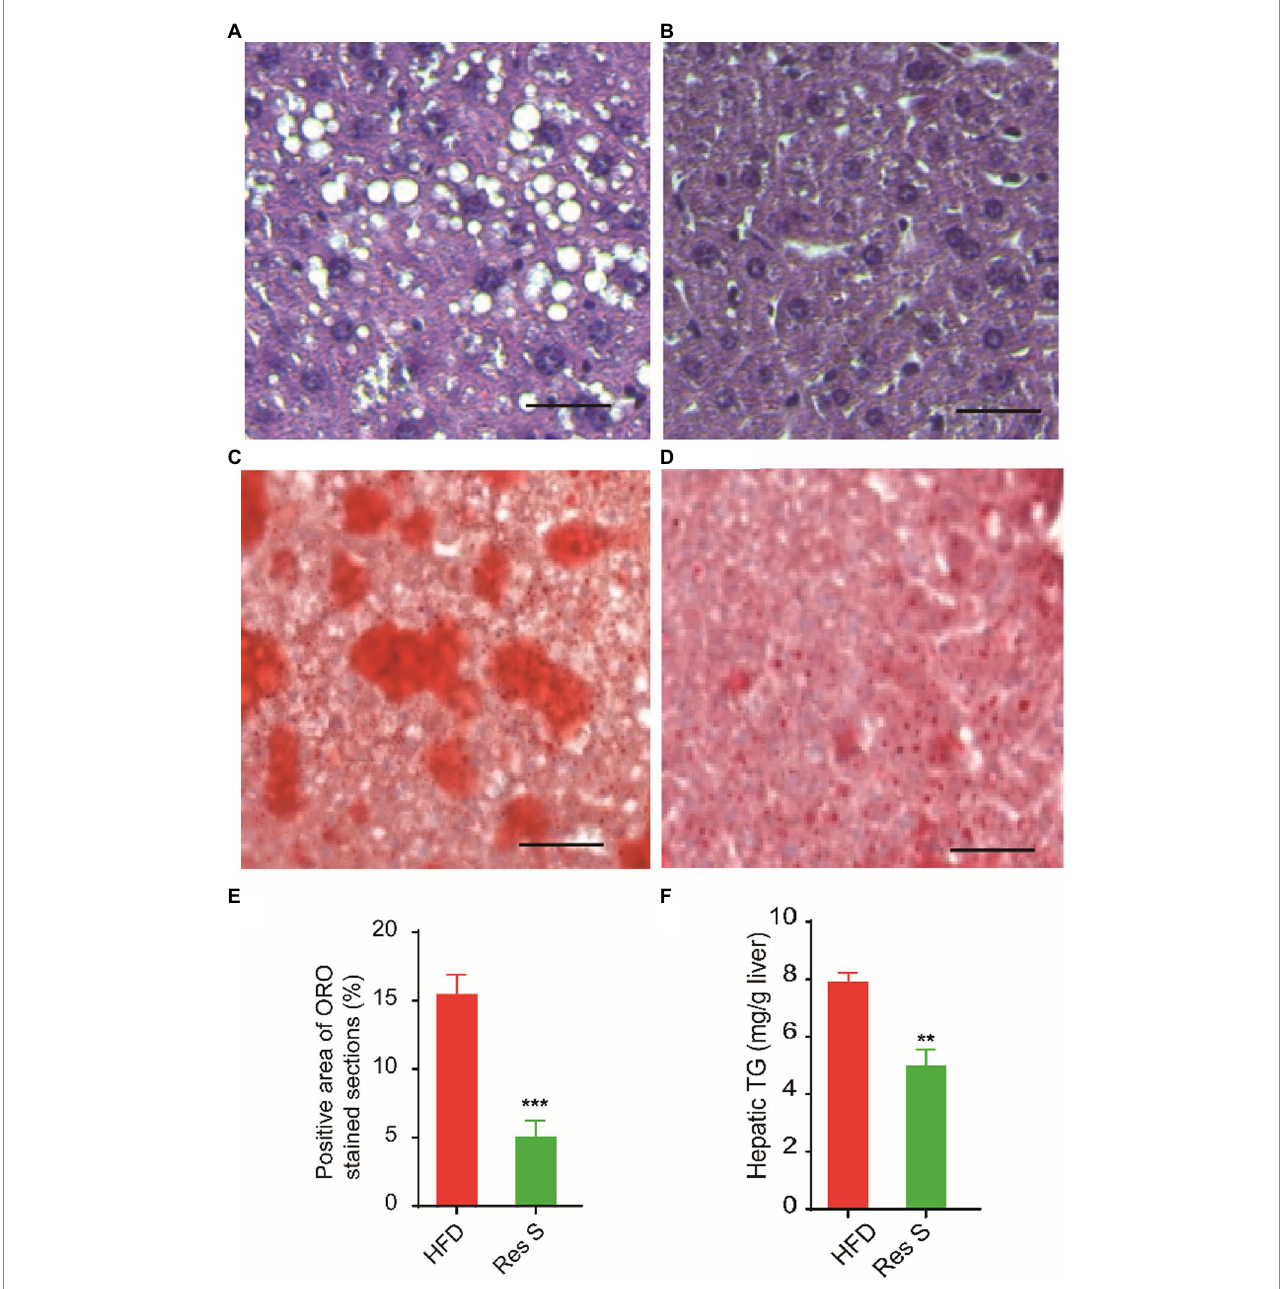
FIGURE 2 Resinacein S reduced liver damage and hepatic steatosis in HFD-fed mice. (A,B) H&E staining of livers in HFD-fed mice (A) and Resinacein S treated HFD- fed mice (B) . (C–E) Oil Red O staining of livers in HFD-fed mice (C) and Resinacein S treated HFD-fed mice (D) . (E) is the quantitative analysis of Oil Red O staining. (F) TG levels in livers of Resinacein S treated or not HFD-fed mice were detected. Values were means ± SD, and for statistical analysis, one-way ANOVA were performed between indicated